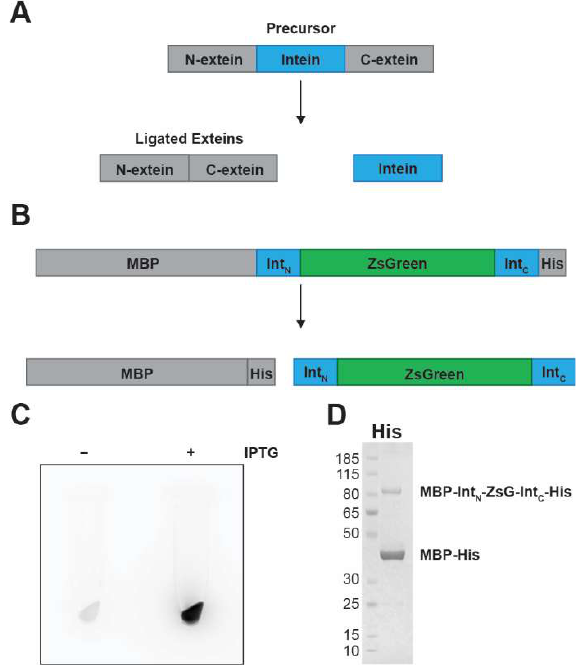
Figure 1. Protein splicing and ZsG-Int fusion splicing in E. coli . ( A ) Diagram of intein-containing precursor protein. Following protein splicing, the two peptide bonds flanking the intein are rearranged into one, linking the N- and C-exteins together (ligated exteins; gray) and releasing the intein (blue). ( B ) Diagram of intein-housing ZsGreen construct (ZsG-Int) for expression in E. coli. Maltose-binding protein (MBP) and a His-tag (His) serve as the exteins. Length is relative to the number of residues. ZsGreen is inserted within the intein, with the upstream (IntN) and downstream (IntC) regions of the intein in blue, and ZsGreen in green. ( C ) E. coli cell pellets containing the MBP-IntN-ZsGreen-IntC-His expression plasmid under 460 nm light. In the absence of the inducer IPTG, cells display minimal fluorescence. However, when grown in the presence of IPTG, cells display strong fluorescence, indicating ZsGreen expression and folding ( D ) ZsG-Int is splicing active following expression in E. coli . MBP-IntN-ZsGreen-IntC-H was expressed and isolated using Ni2+-affinity resin. Eluate from Ni2+-affinity resin was separated by SDS-PAGE and stained by Coomassie Brilliant Blue. Major product is consistent in size with the expected ligated exteins, MBP-His (43.2 kDa). Minor product is consistent in size with the expected unspliced precursor, MBP-IntN-ZsGreen-IntC-His (89.4 kDa).